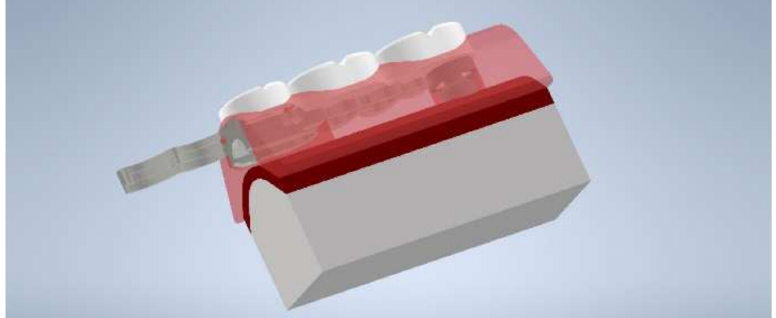
Figure 2. The 3D Model of the unilateral mandibular RPD with distal implant.